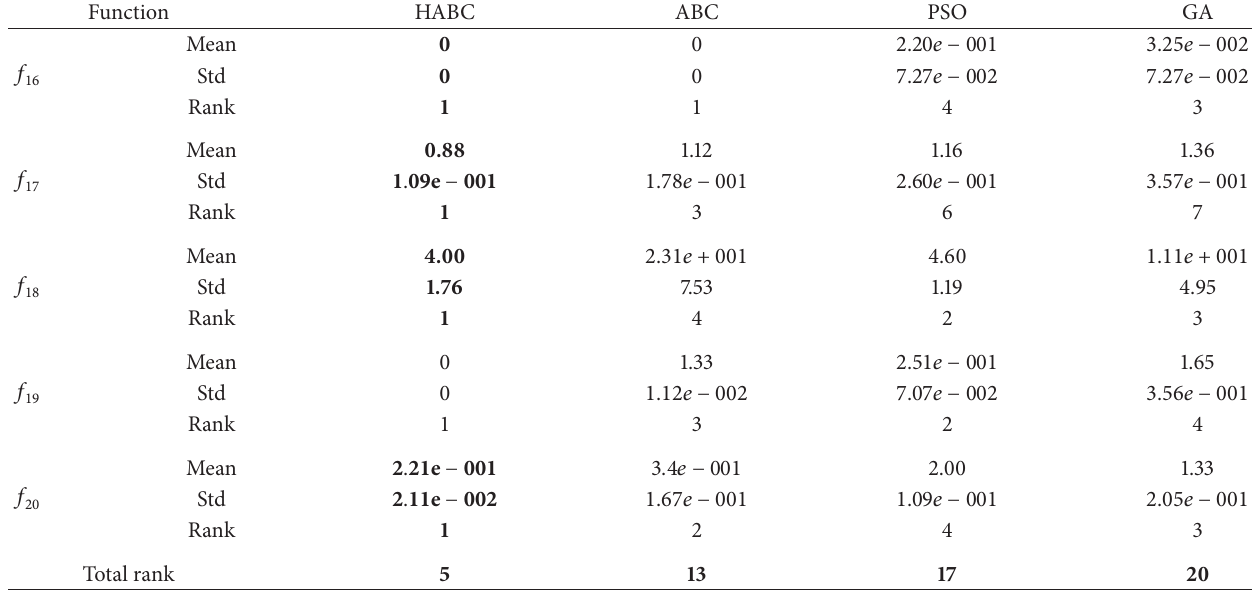
Table 8: Performance of all algorithms on benchmark discrete functions 𝑓 16 – 𝑓 20 .